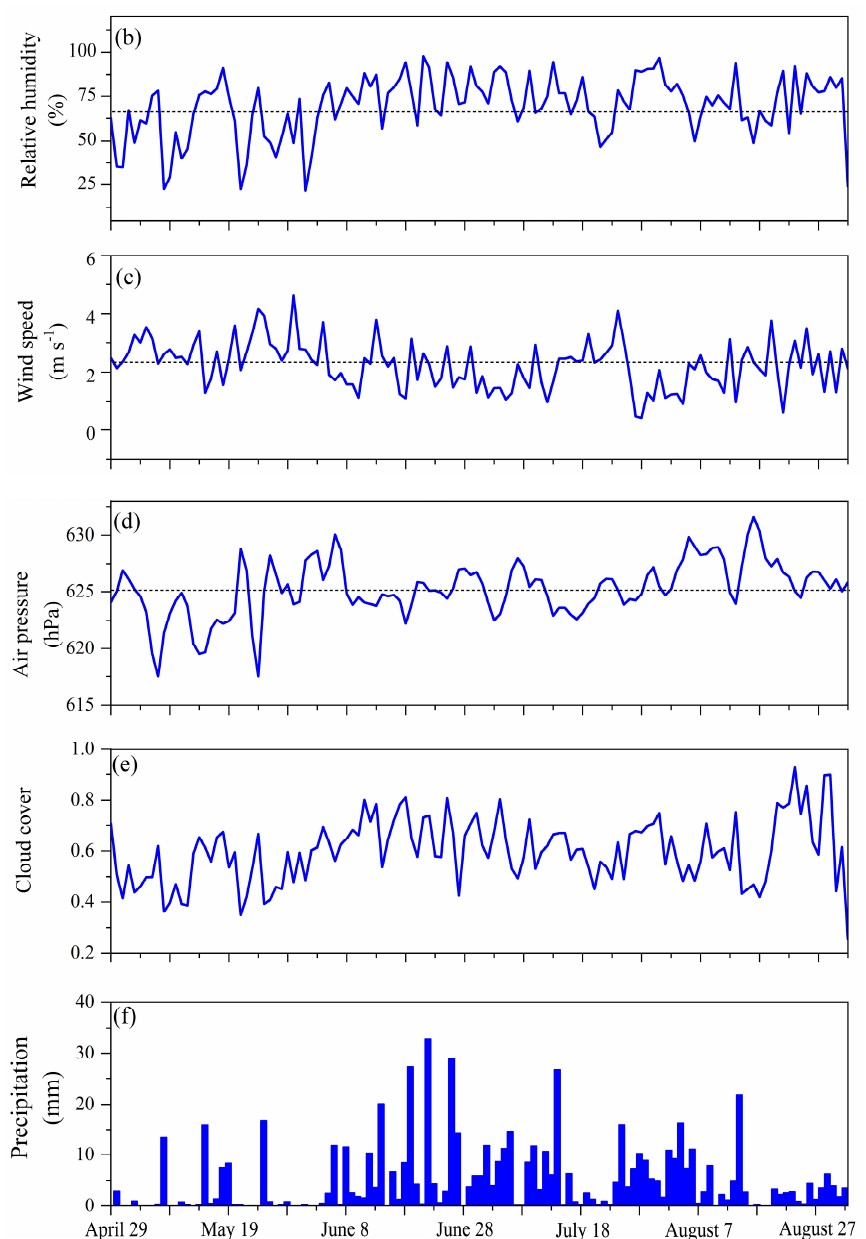
Figure 2. Daily mean values of ( a ) air temperature, ( b ) relative humidity, ( c ) wind speed, ( d ) air pressure, ( e ) cloud cover, and daily total precipitation ( f ) of AWS1 on the east branch of UG1 during the ablation period from 29 April to 1 September